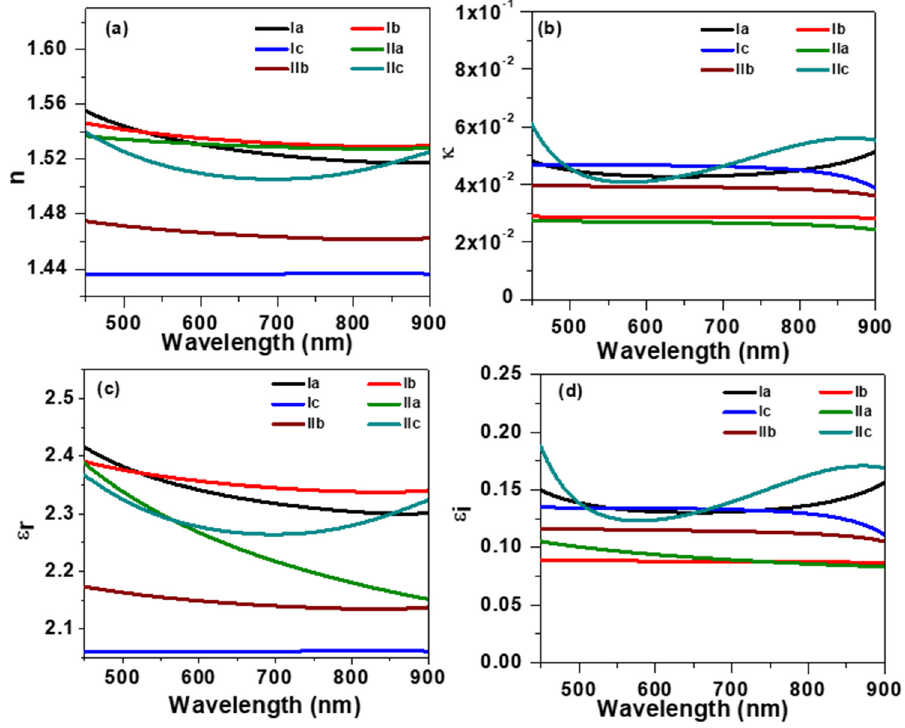
Figure 9. The optical constants of liquid crystalline materials extracted with spectroscopic ellipsometer measurement; (a) refractive index; (b) extinction coefficient; (c),(d) dielectric contents